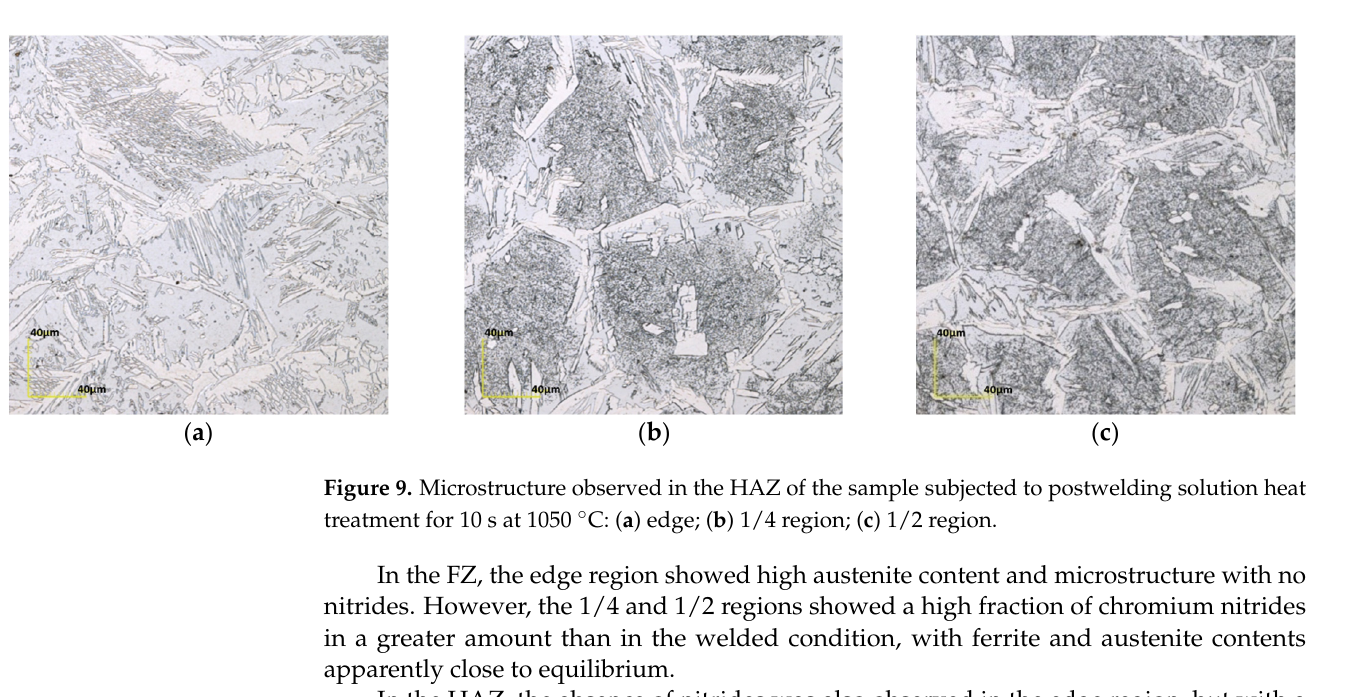
Figure 8. Microstructure observed in the FZ of the sample subjected to postwelding solution heat treatment for 10 s at 1050 °C: ( a ) edge; ( b ) 1/4 region; ( c ) 1/2 region.